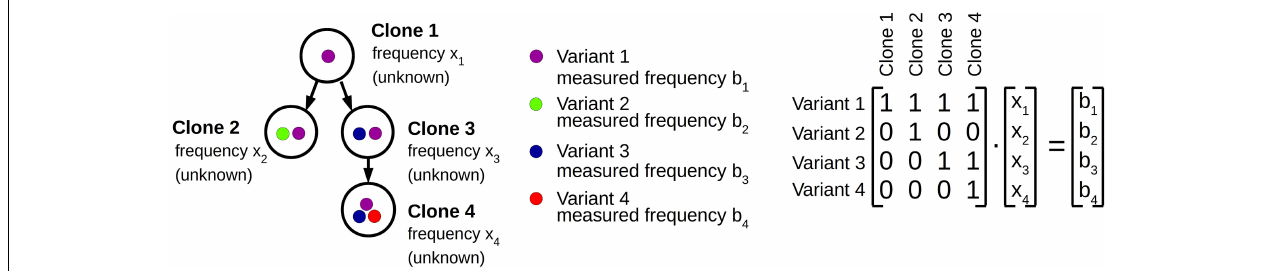
FIGURE 1 | Computational approach. Clonal hierarchies are rooted trees. The root of the tree either corresponds to wild type cells or to the AML founder clone. The colored dots represent different alleles or mutations. From bulk sequencing the allele frequencies b i in the sample are known. The frequencies x i of the different clones are unknown. The tree structure is represented by a triangular matrix. The measured data is compatible with the tree structure if the system Ax = b has a non-negative solution.